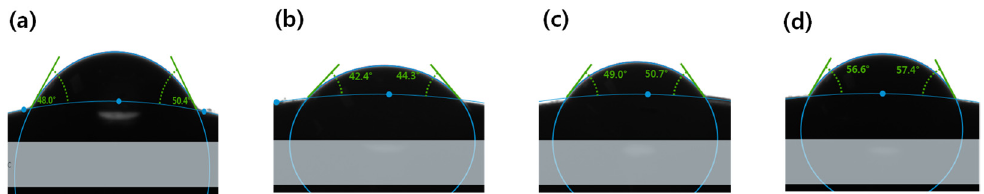
Figure 11. Contact angle image of ( a ) Ref sample, ( b ) M0.05N5 sample, ( c ) M0.1N5 sample, ( d ) M0.1N5S1 sample.